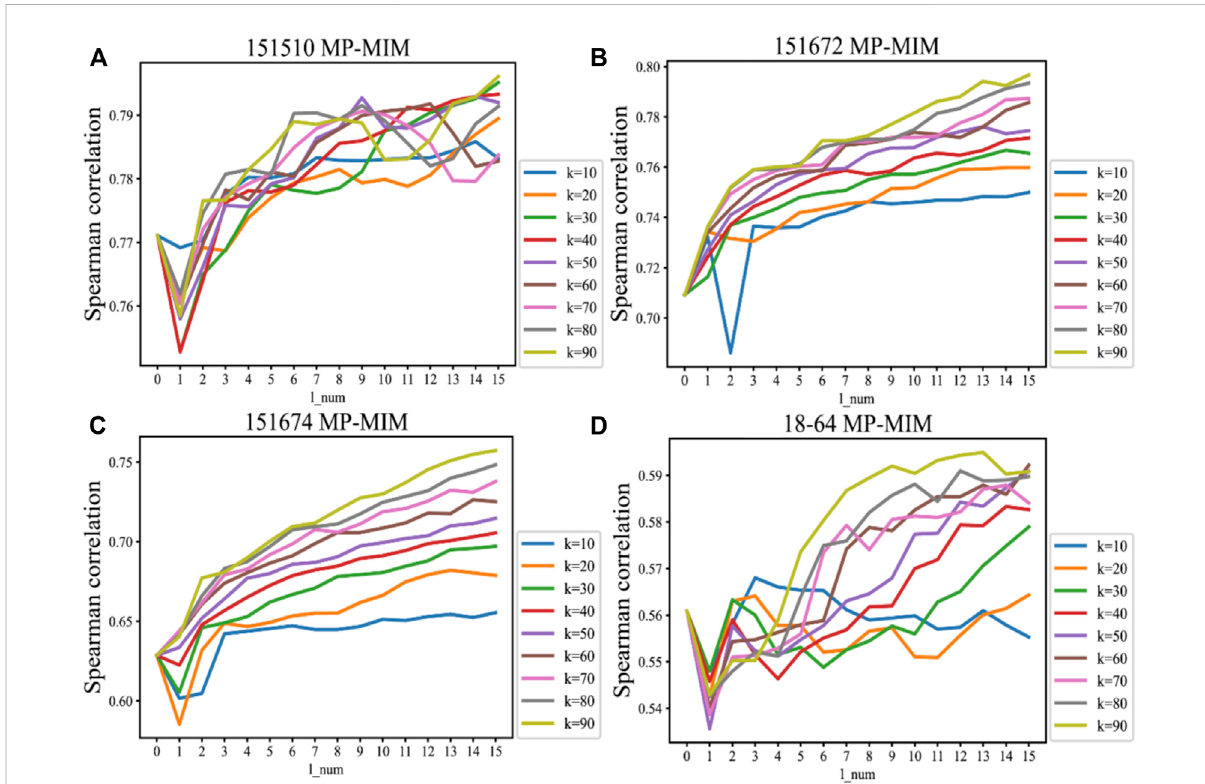
FIGURE 4 Sensitivitiesofthehyperparameters k_num and l_num inmessagepassingtotheSpearmancorrelationonthefollowingsamples: (A) 151510, (B) 151672, (C) 151674, and (D) 18 – 64. The horizontal axis represents the number of layers in the message passing. The vertical axis represents the Spearman correlation measured by the ground-truth ranking and the ranking of the MP-MIM. k denotes the number of nearest neighbors, which is the prede fi ned parameter in the KNN